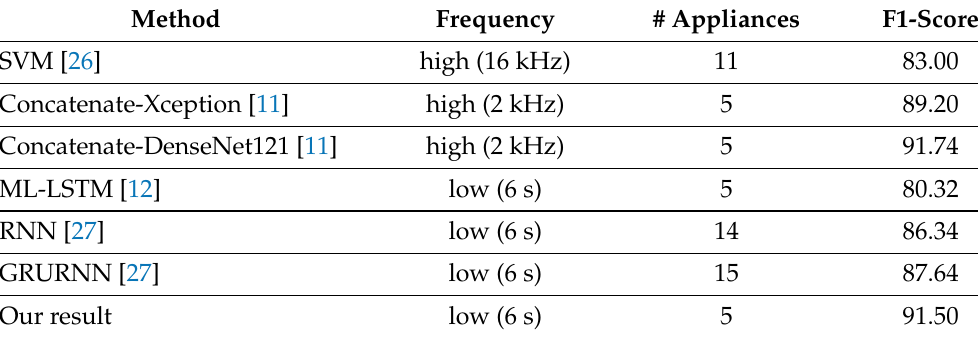
Table 14. The performance of the appliance classification on the UK-DALE